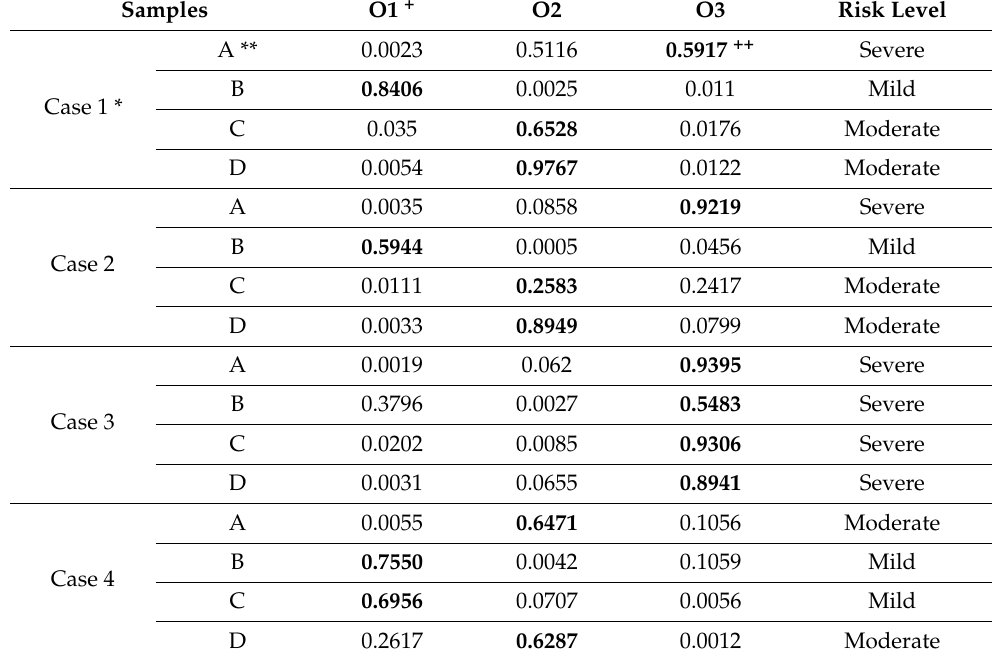
Table 6. A comparison of the output values and risk levels of the four established BPNN models with the four typical